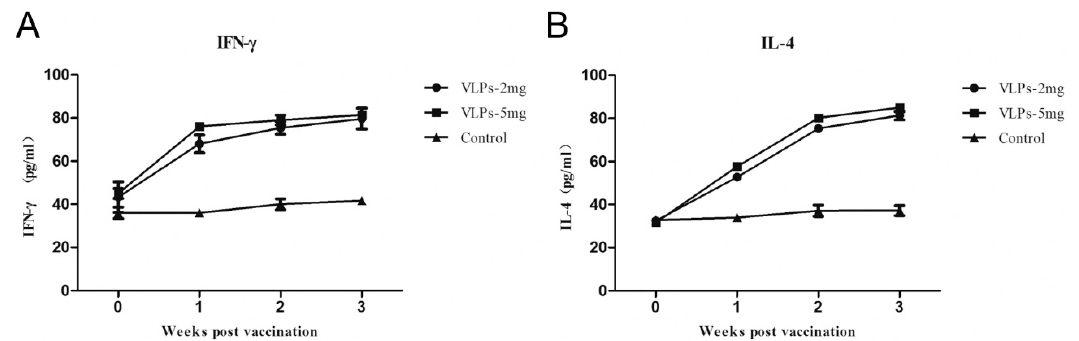
Figure 5. Production of cytokines IFN- γ ( A ) and IL-4 ( B ) in rabbits after immunization. The rabbit sera collected were used to analyse the serum levels of IFN- γ and IL-4 by ELISA. The IFN- γ and IL-4 level of rabbits immunized subcutaneously with 2 mg or 5 mg VLPs were both significantly higher as compared to the control group, but not different from each other.